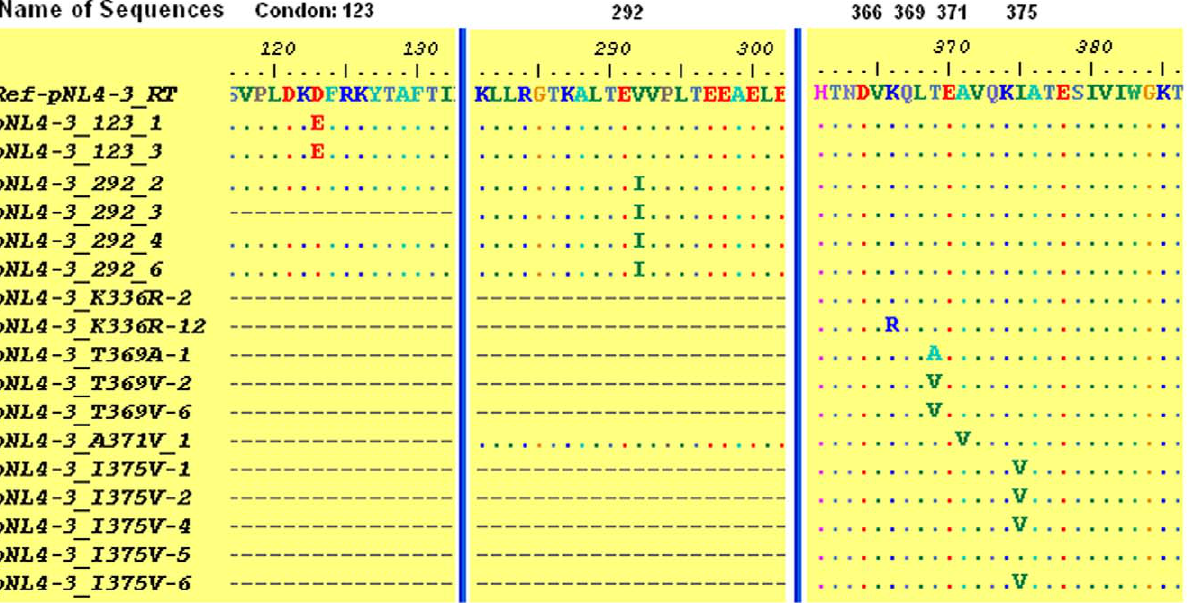
Figure 1. Sequencing results of the constructed plasmid pNL4-3 with mutations. All sequences were obtained from a single colony, and sequencing results from the supernatant/harvest virions matched the sequence from the single colony, suggesting that the mutations were not altered during transfection and infection. doi:10.1371/journal.pone.0047119.g001 PLOS ONE |